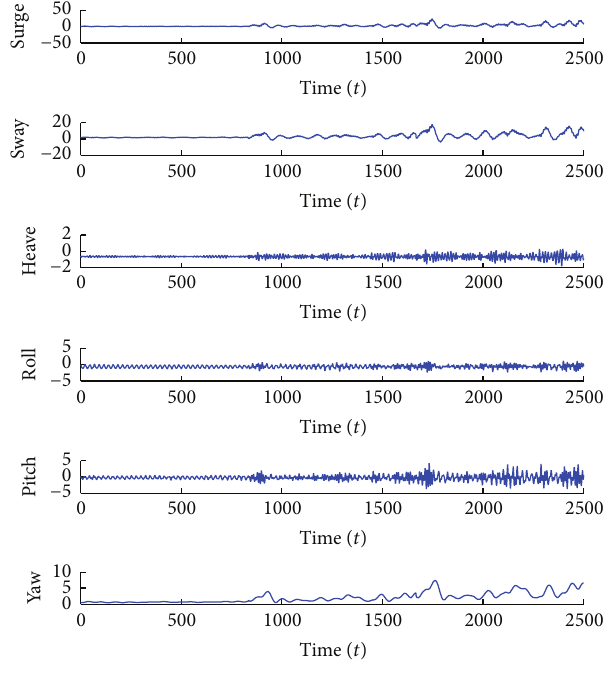
Figure 4: Platform motion used as ANN training input data.